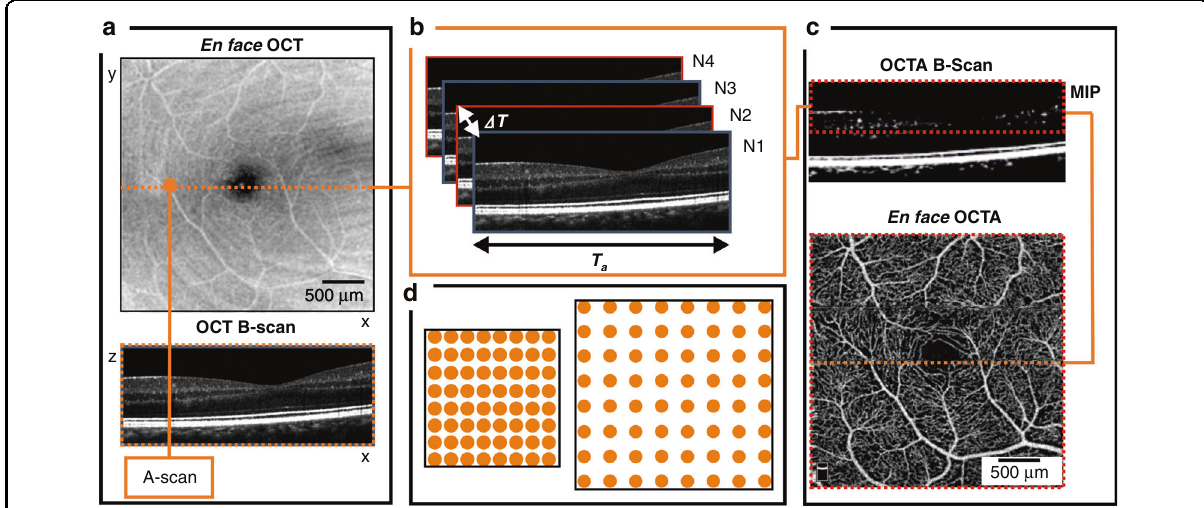
Fig. 5 Simpli fi ed schematic of OCTA scanning protocol. a A raster scanning protocol is applied to visualize blood vessels; A-scans per B-scan sets x -axis sampling density; B scans per volume sets y -axis sampling density. b Four repeated B-scans at one y -location are used to create an OCTA B- scan; the procedure is repeated for successive positions along the y -axis; the fi nal number of OCTA B-scans impacts on sampling density along y -axis; Δ T — interscan time; T — acquisition time. c Maximum intensity projection (MIP) is applied to OCTA B-scan over depth range of interest (where vessels a are located) to generate one line of the en face OCTA image. d Illustration of how the same number of sampling points is distributed for smaller and larger imaging